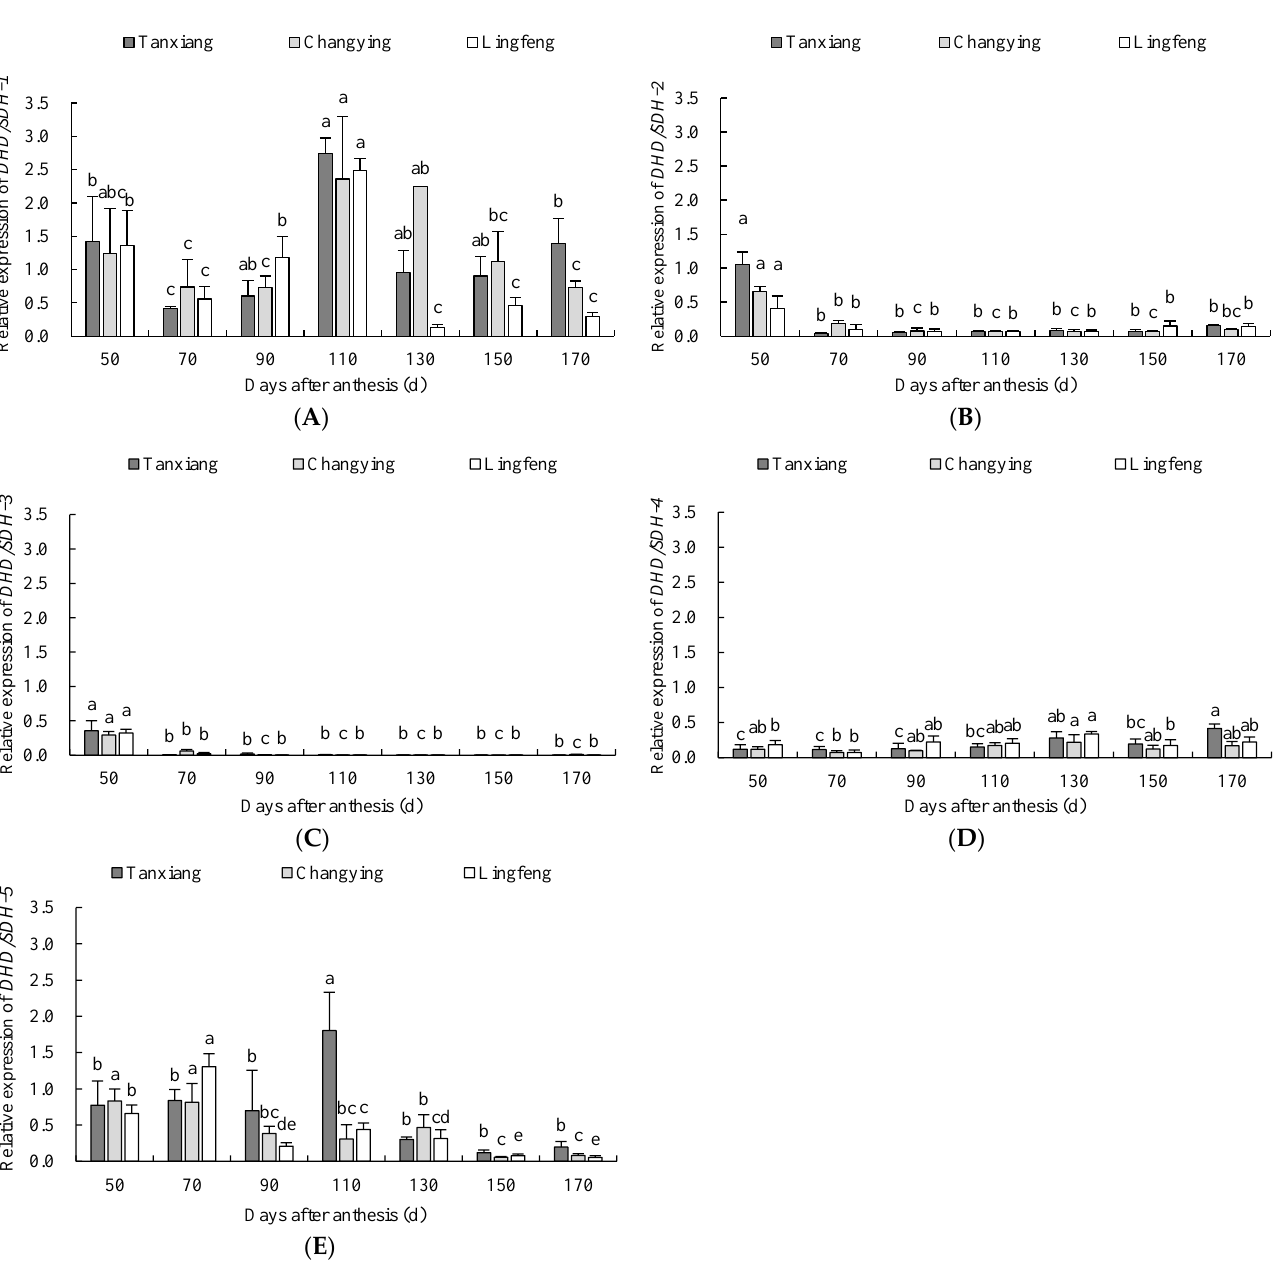
Figure 6. Expression of CS in Chinese olive fruit at different developmental stages. Bars represent the standard deviation for three biological replicates. Different letters indicate significant differences among different stages of the same cultivars ( p < 0.05). 3.2.5. Expression Changes of CMs bc